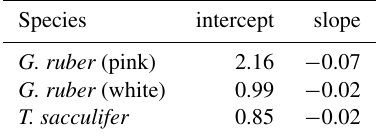
Table 1. Temperature-amplitude relationships for the modelled flux pattern of tropical species based on Jonkers and Kucera (2015).